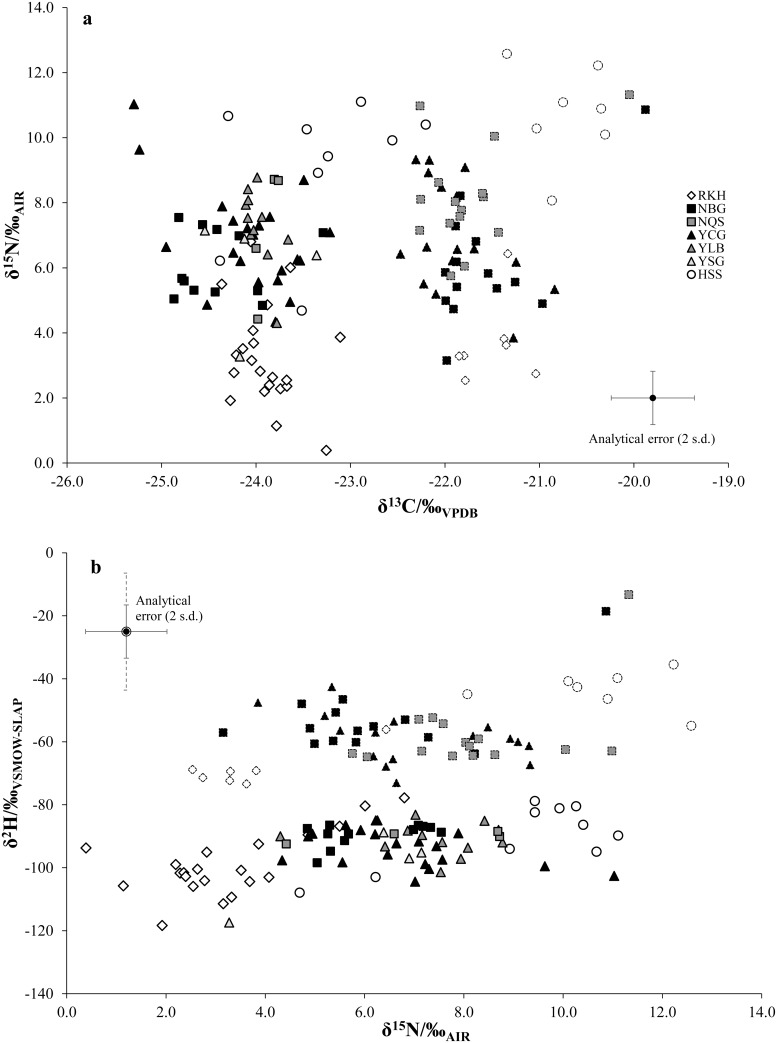
(a) δ13C vs δ15N values and (b) δ15N vs δ2H values for wool keratin samples (heavy solid outline) and bone collagen samples (light dotted outline).